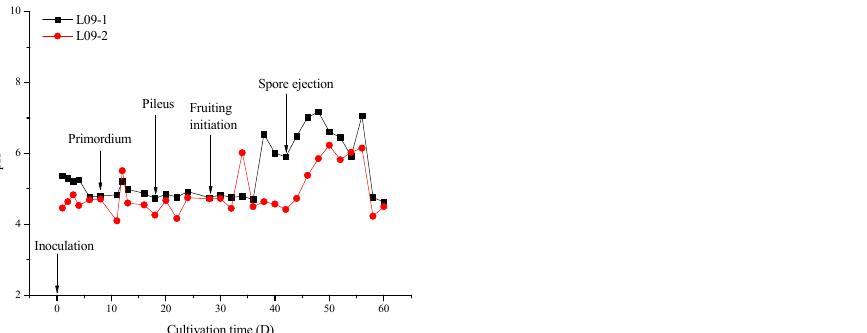
Figure 1. pH values of germ substrates of two G. lucidum from inoculation to fruiting. Arrows point to several important growth stages. The pH decreased before every stage of growth point, especially before spore ejection. The pH of L09-1 (5.36) decreased to 4.63 from the inoculation to the end of first fruiting, and the pH of L09-2 showed little change from 4.46 to